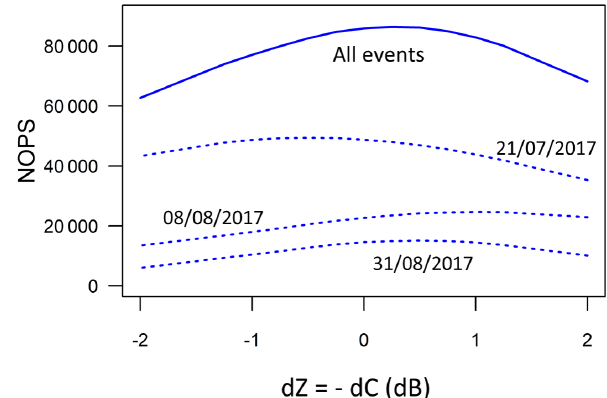
Figure 8. Evolution of the total number of optimal parameter sets (NOPSs) as a function of the radar calibration error for three con- vective events separately (dotted blue curves) and all together (solid blue curve). The other fixed parameters for these simulations are b AZ = 0 . 8 and b AK = 1 . 1.